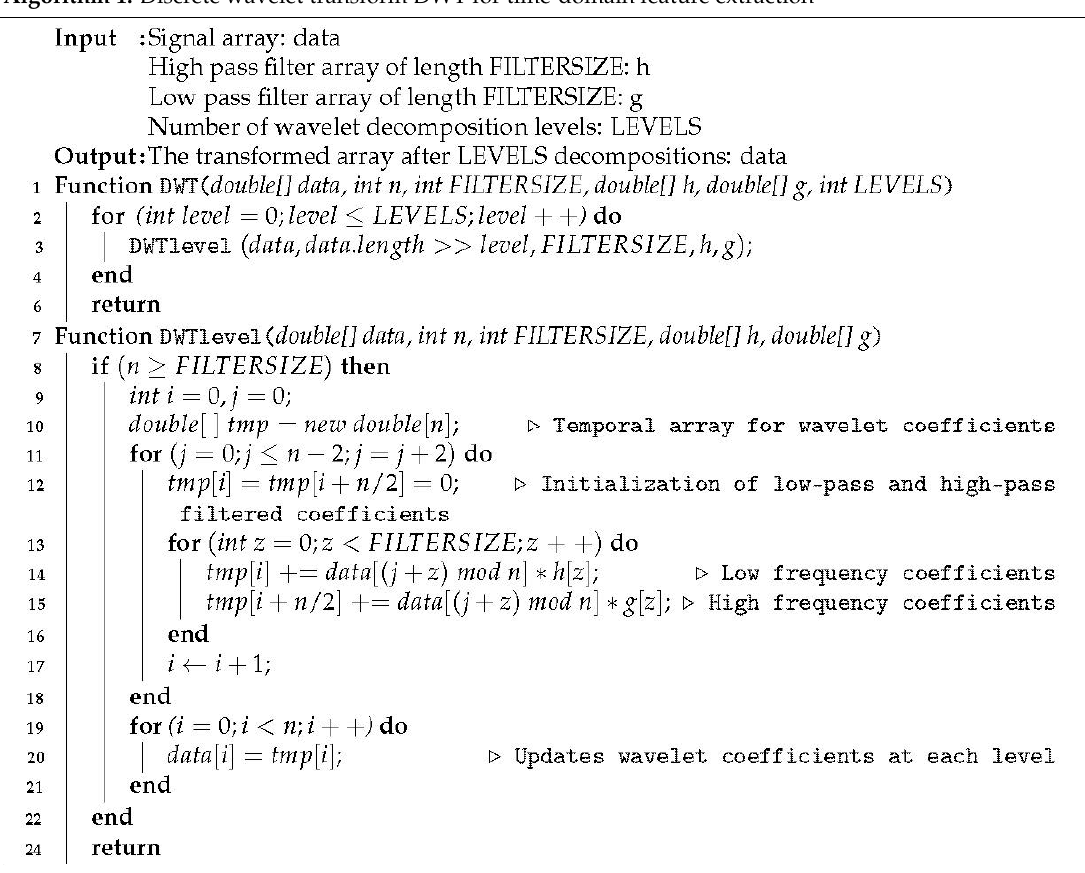
Algorithm 1: Discrete wavelet transform DWT for time-domain feature extraction